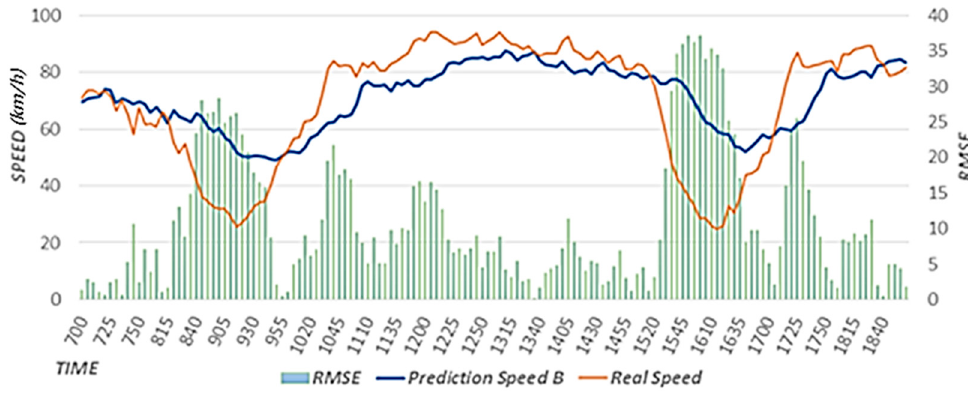
Figure 17. Predicted speed considering the event weight.